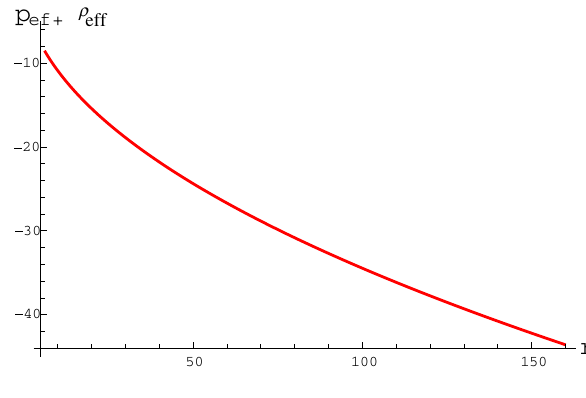
is located at r 0 = 7 and h ( r 0 ) = r 0 in the background of phantom energy ( w = −